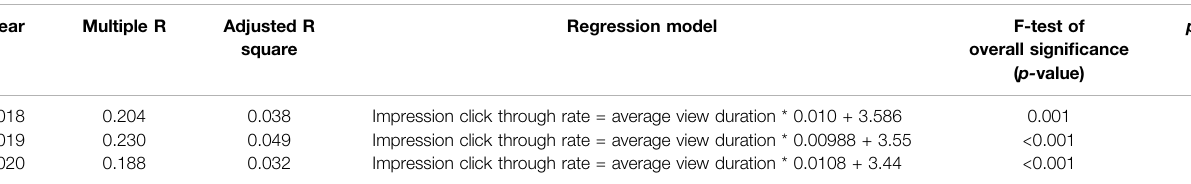
TABLE 1 | Linear regression analysis of impression click-through rate.